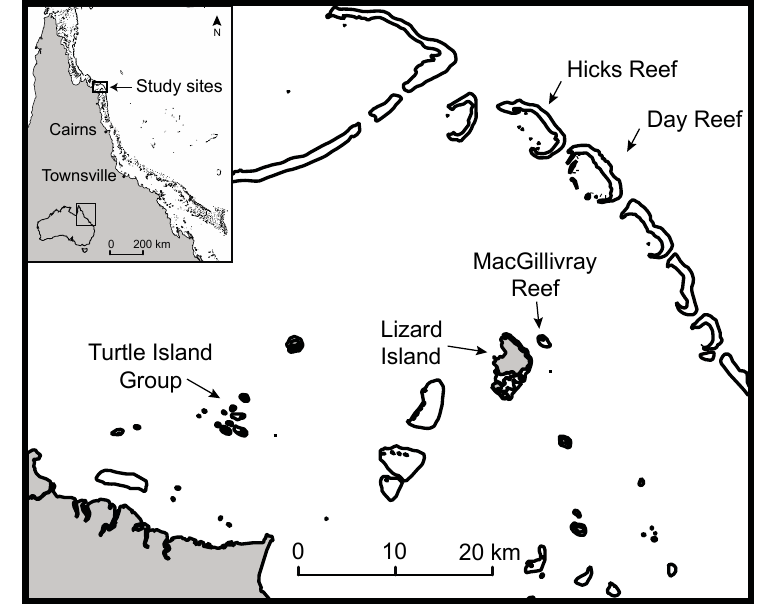
Figure 1. Map of the study area (modified from [23]).